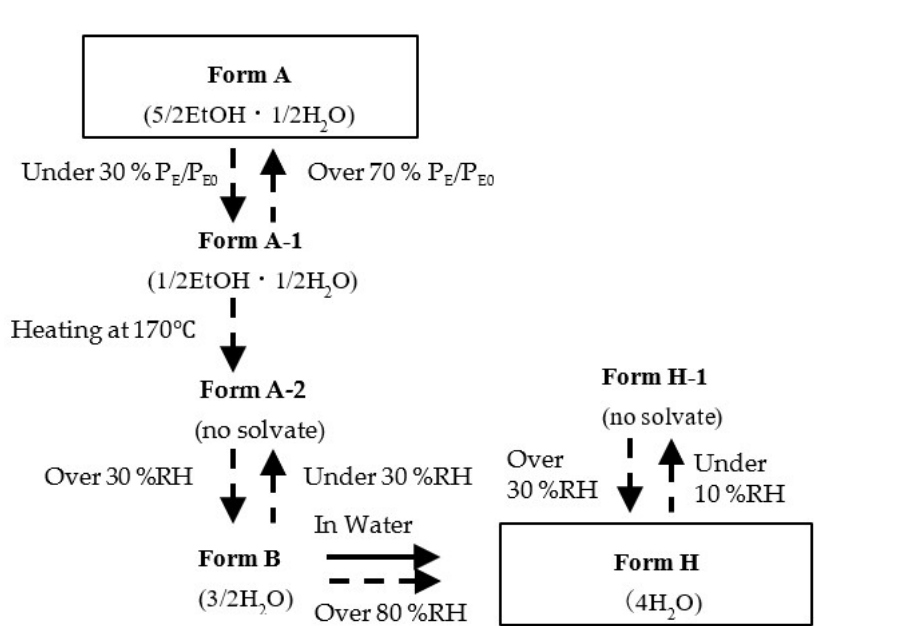
Figure 13. A solid-phase transition diagram from Form A prepared by poor solvent crystallization to Form H.